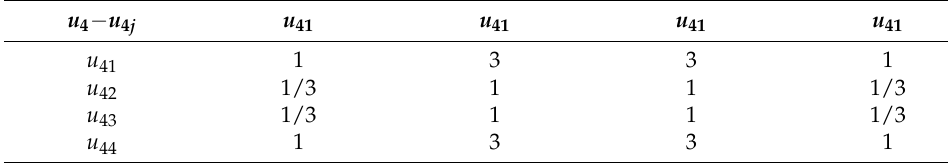
Table 6. Judgment matrix of u 4 − u 4 j .